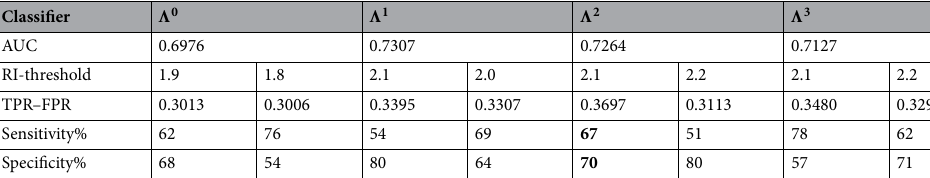
Table 2. Statistical measure of the performance of the classifiers and AUC. The sensitivity and specificity obtained for the best performing classifier-refractive index threshold association is given in